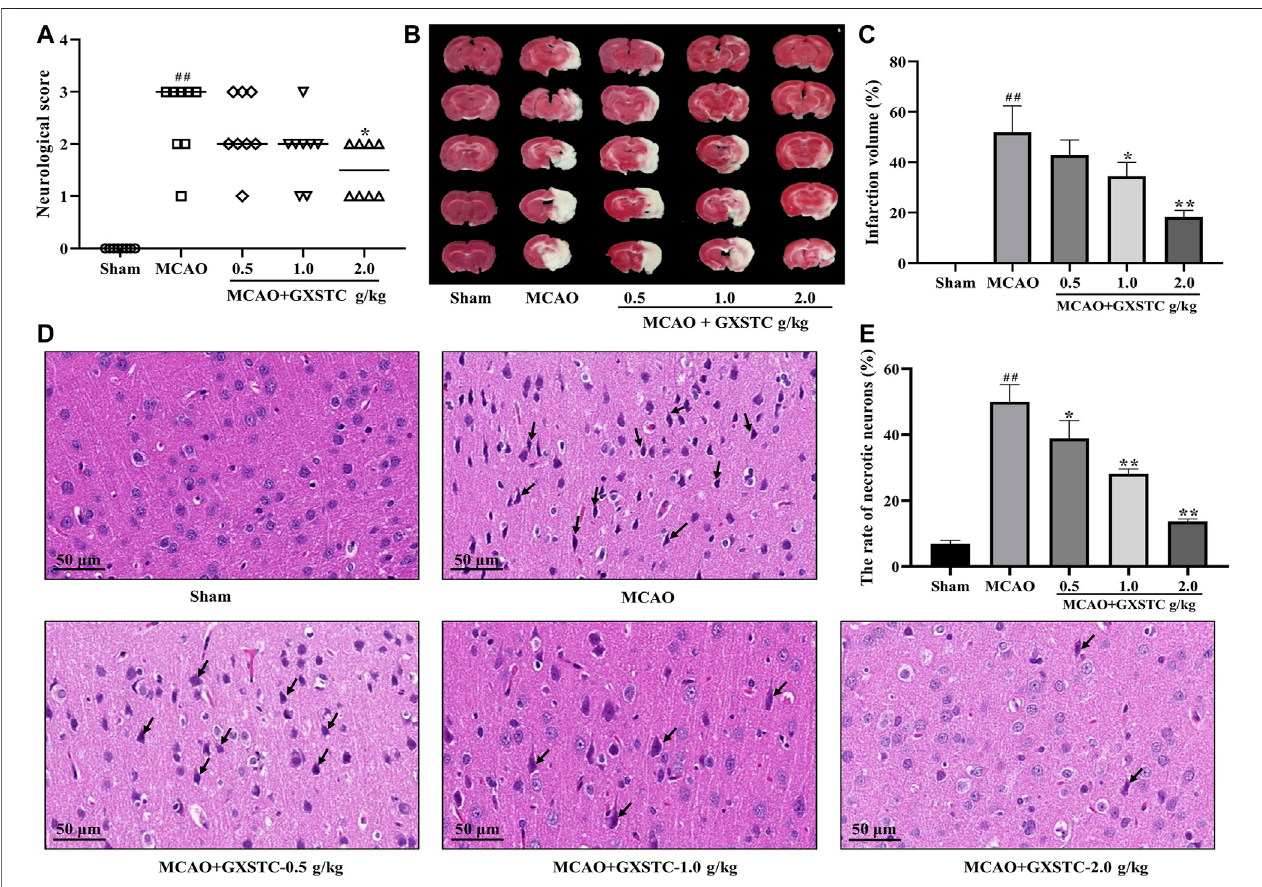
FIGURE 8 | GXSTC alleviates MCAO-induced brain injury (A) Scatterplot of the neurological de fi cits in the sham, MCAO, 0.5, 1.0, 2.0 g/kg GXSTC pretreatment groups(datawereexpressedasmedian, n (cid:2) 8) (B) Thecerebralinfarctvolumeofratsineachgroup (C) Statisticalanalysisoftherateofinfarctvolumeineachgroup (D) H and E staining of coronal slices of the ischemic cerebral cortex, and the black arrow points to necrotic neurons (E) Statistical analysis results of the rate of necrotic neurons in each group. All data, except for neurologic score, were expressed as mean ± SD; ## p < 0.01, compared with the sham group; * p < 0.05 or ** p < 0.01, compared with the MCAO